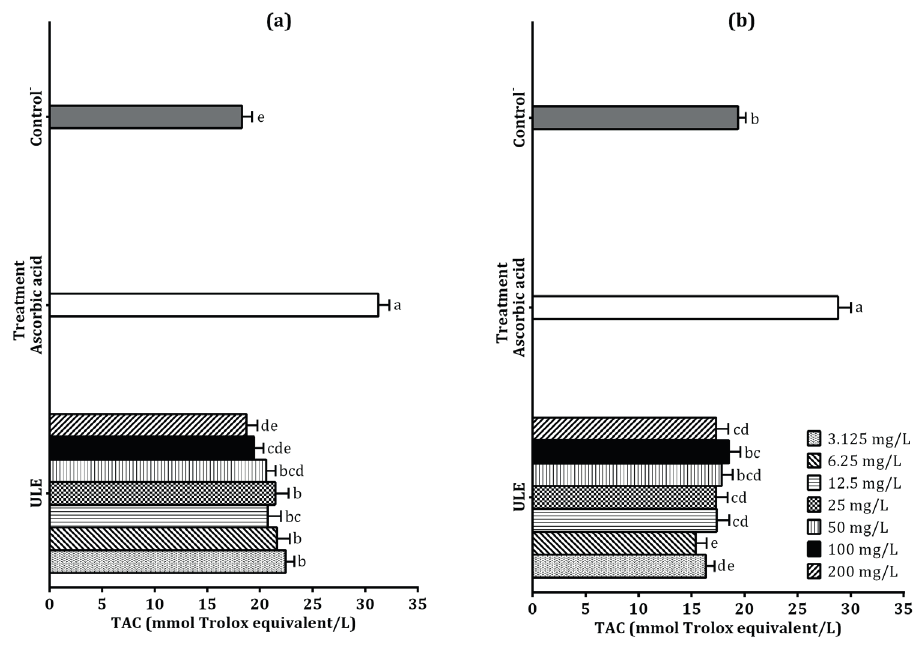
Figure 4 - TAC levels in the cells in the presence of ULE (a) for PMGN cells (b) for U87MG cells. each value is expressed as mean ± standard deviation ( n = 3). Values followed by different small letters differ significantly at p < 0.05.